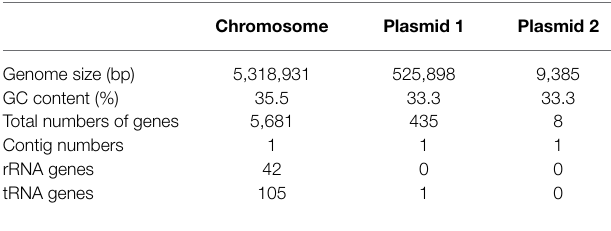
TABLE 3 | Genome features of strain